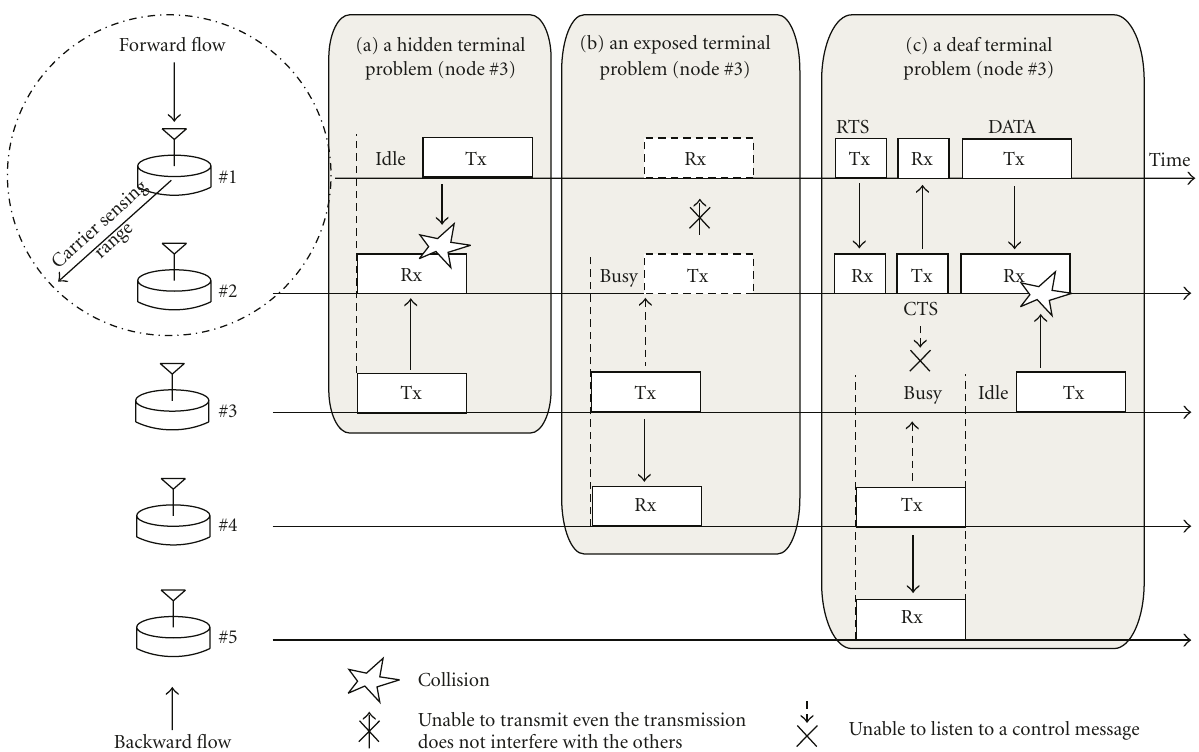
Figure 3: Associated issues of CSMA/CA in 1D mesh network with bidirectional flows. (Transmission range is assumed to be the distance between any two adjacent nodes in this